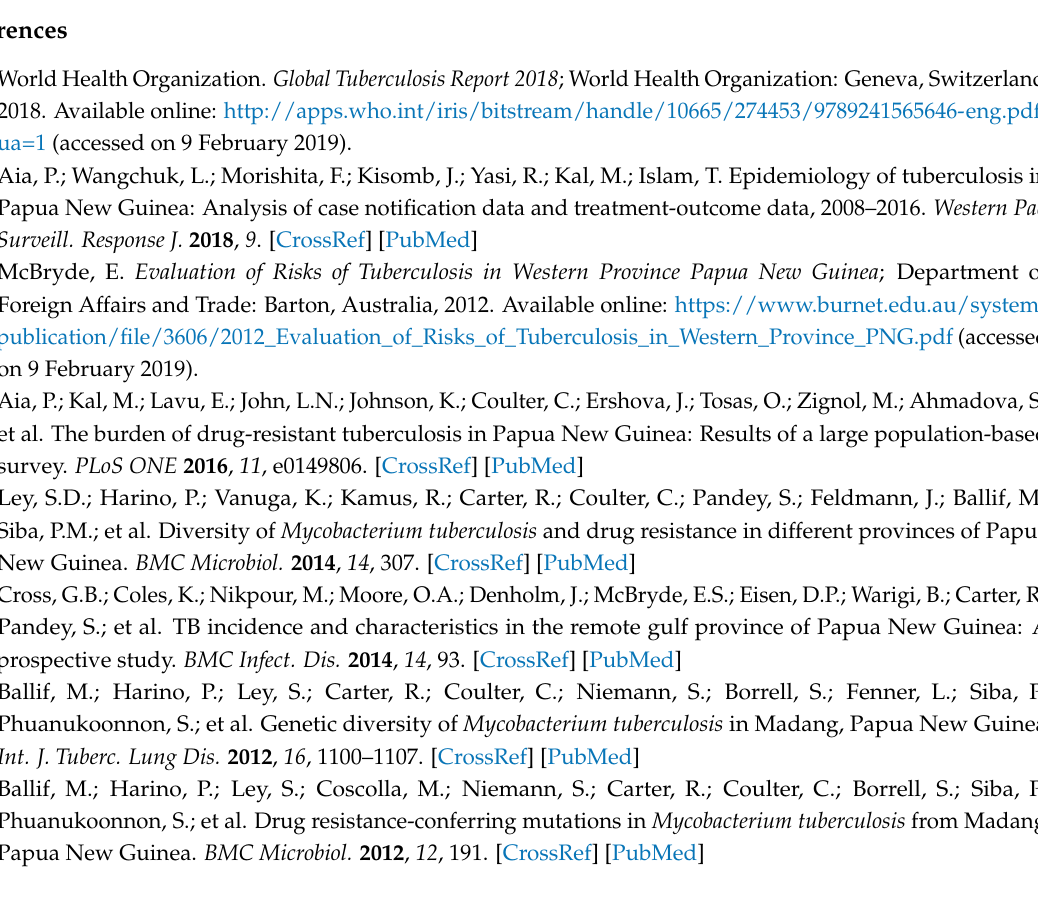
Table S1: Details of qPCR and sequencing